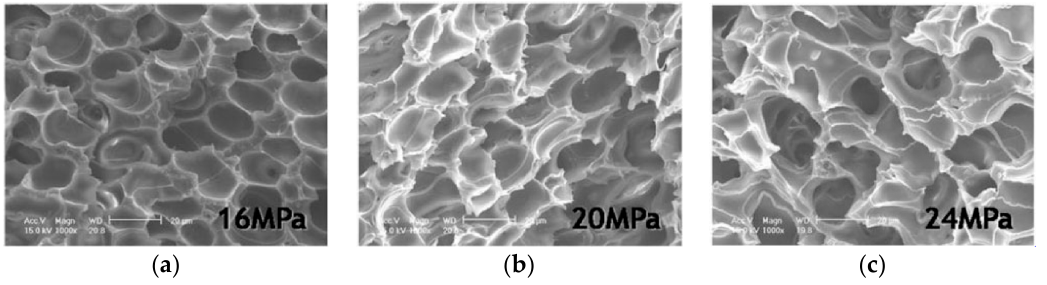
Figure 10. Effect of pressure on cell morphology of PLA/silk foams (7 wt%, 155 °C) at ( a ) 16 MPa, ( b ) 20 MPa, and ( c ) 24 MPa. Reprinted from Kang et al. [129]. Copyright © 2020 WILEY-VCH Verlag GmbH & Co. KGaA, Weinheim.